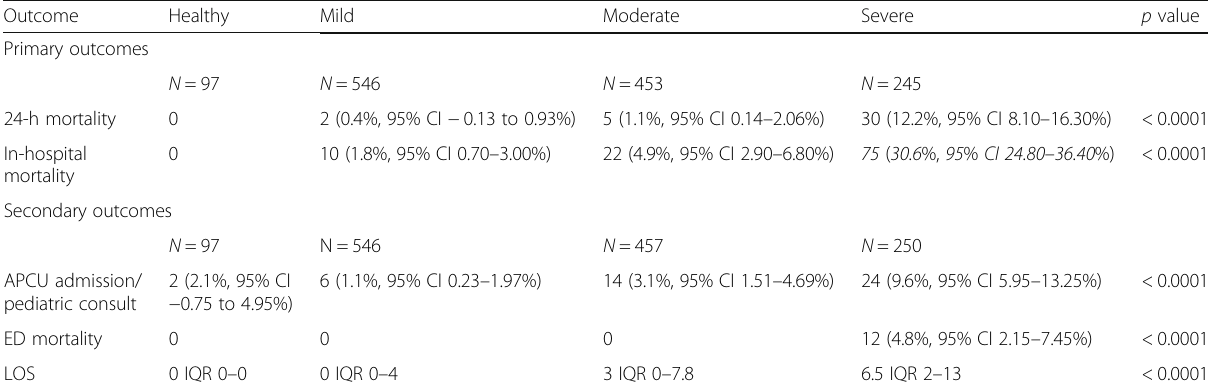
Table 3 Primary and secondary outcomes by provider gestalt category Outcome Healthy Moderate